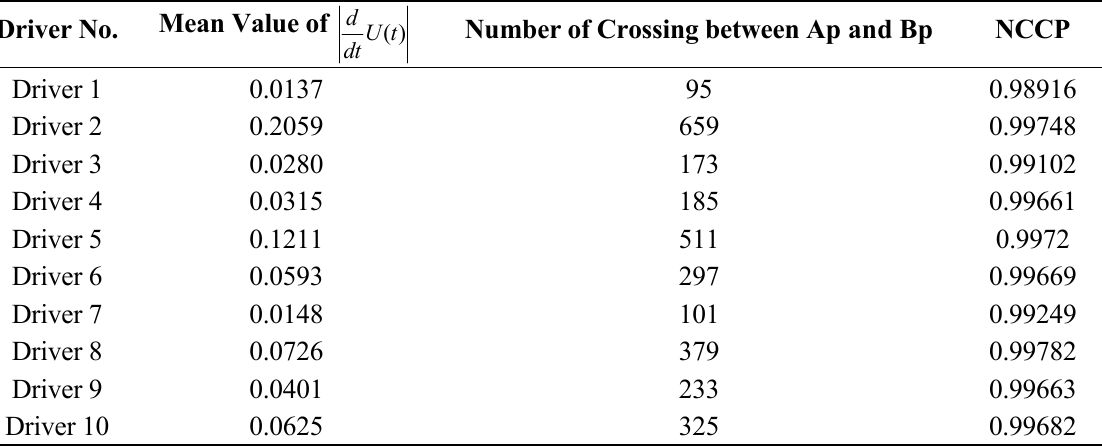
Table 2. Mean value of , the number of crossing between accelerator pedal position (Ap) and brake pedal position (Bp) and normalized cross correlation power (NCCP) for the FTP-72 driving